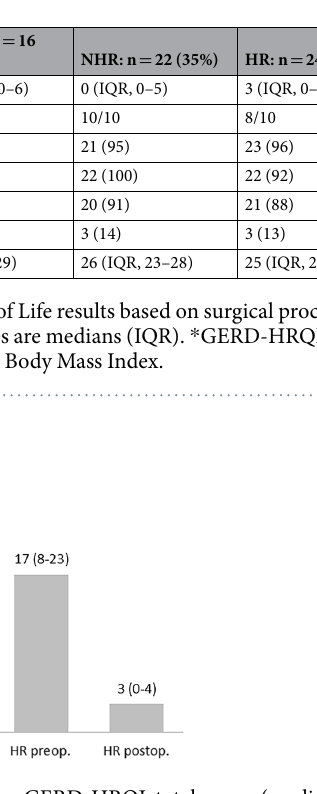
Figure 1. Comparison of pre- and postoperative GERD-HRQL total scores (median with IQR) between groups (NHH left, NHR group mid, HR group right); the maximum total score reachable is 50, with a lower score indicating a better QOL.